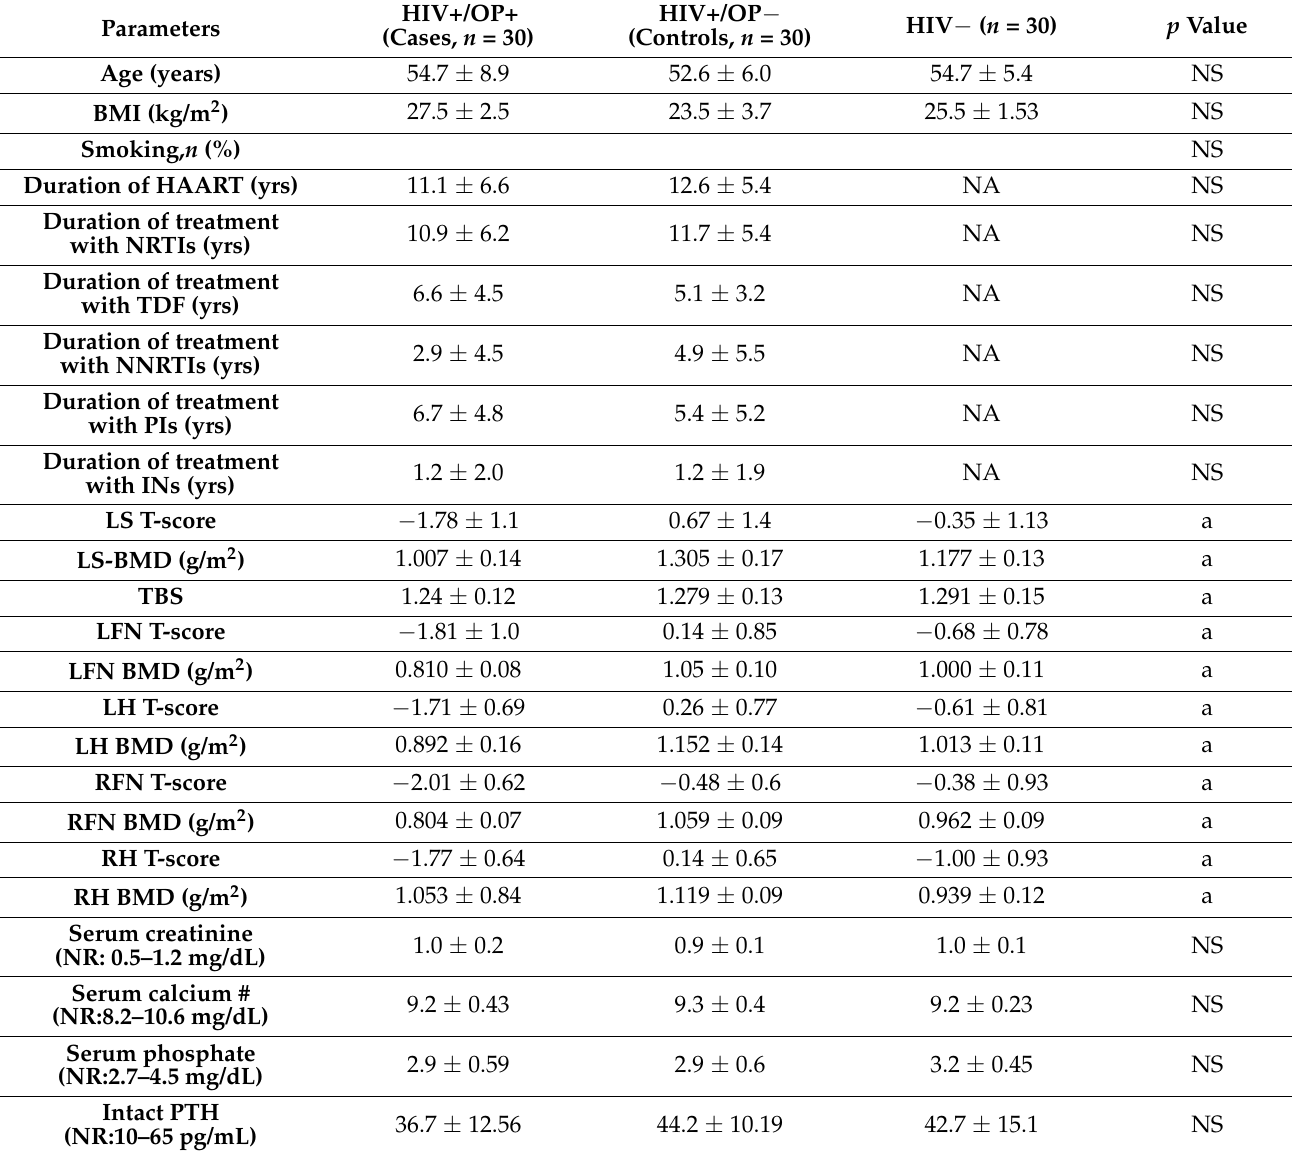
Table 2. Anthropometric and clinical characteristics and biochemical values of the study cohort.